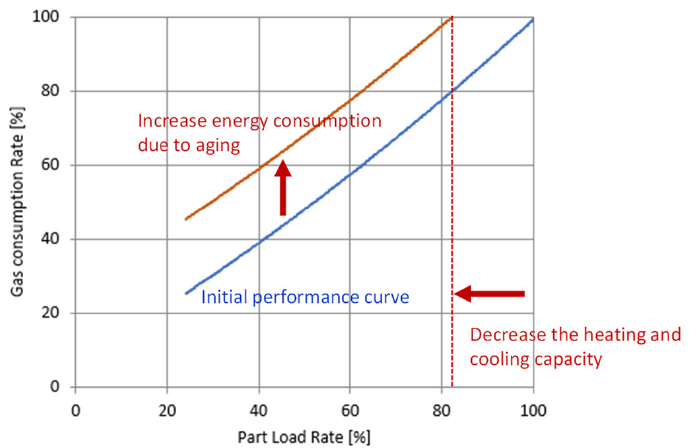
Figure 6. Concept of performance degradation of heat source equipment. (1) Operation unit number control for heat source equipment